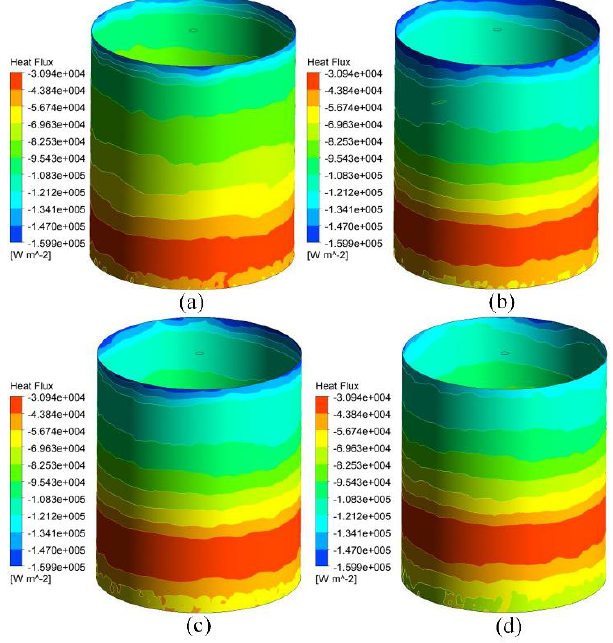
Figure 15. The heat flux through the wall of four stirred tanks with different blade heights. ( a ) h = 30 mm, ( b ) h = 40 mm, ( c ) h = 50 mm, ( d ) h = 60 mm, t = 1 s.